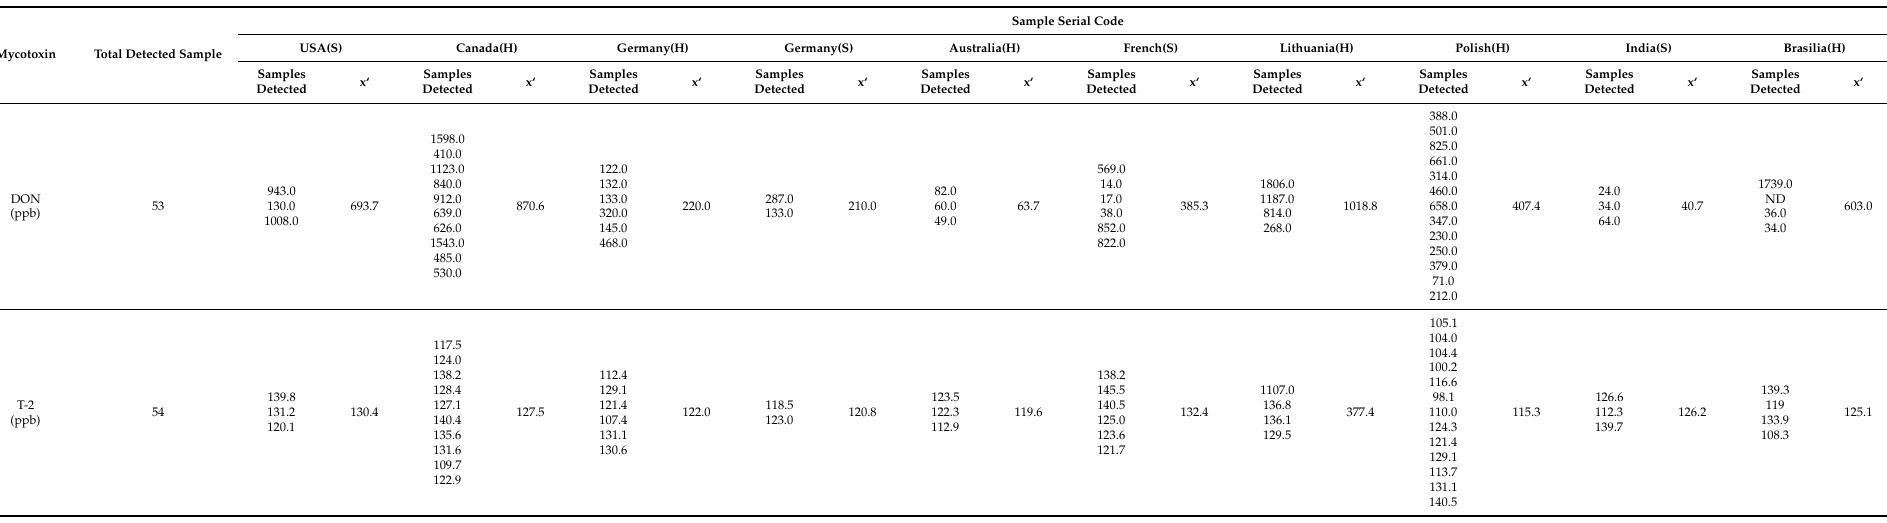
Table 3. Determination of deoxynivalenol (DON) and T-2 toxins (ppb) in different imported wheat grains from different origin countries.